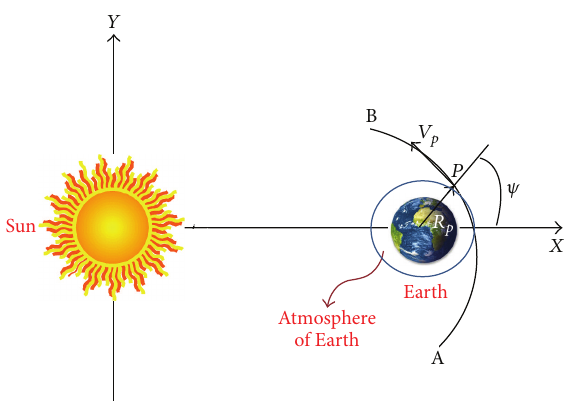
Figure 1: Geometry of the